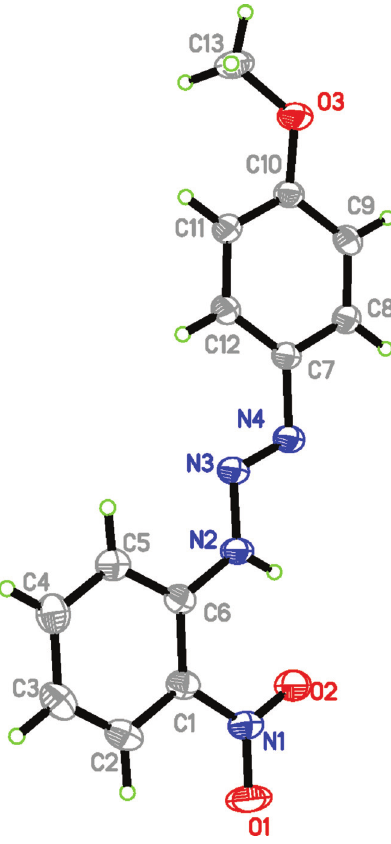
Table 1: Data collection and